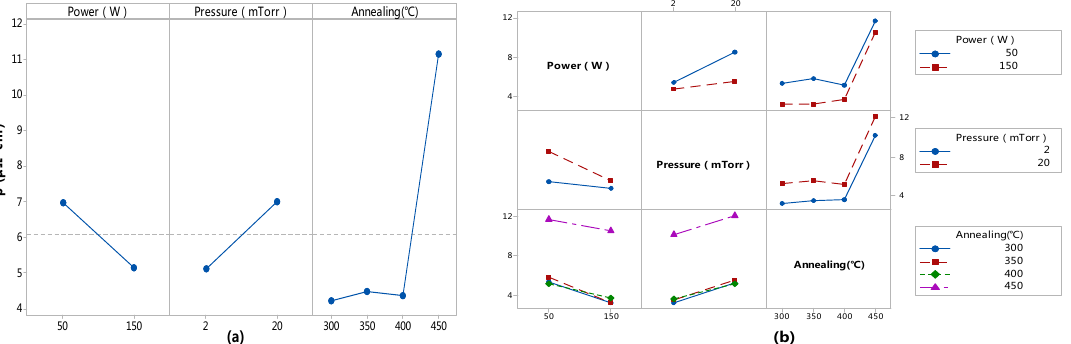
Figure 1. ( a ) Main effects plot and ( b ) interaction plot for the resistivity of Cu-Cr-Zr thin films affected by sputter power, sputter pressure, and annealing temperature.